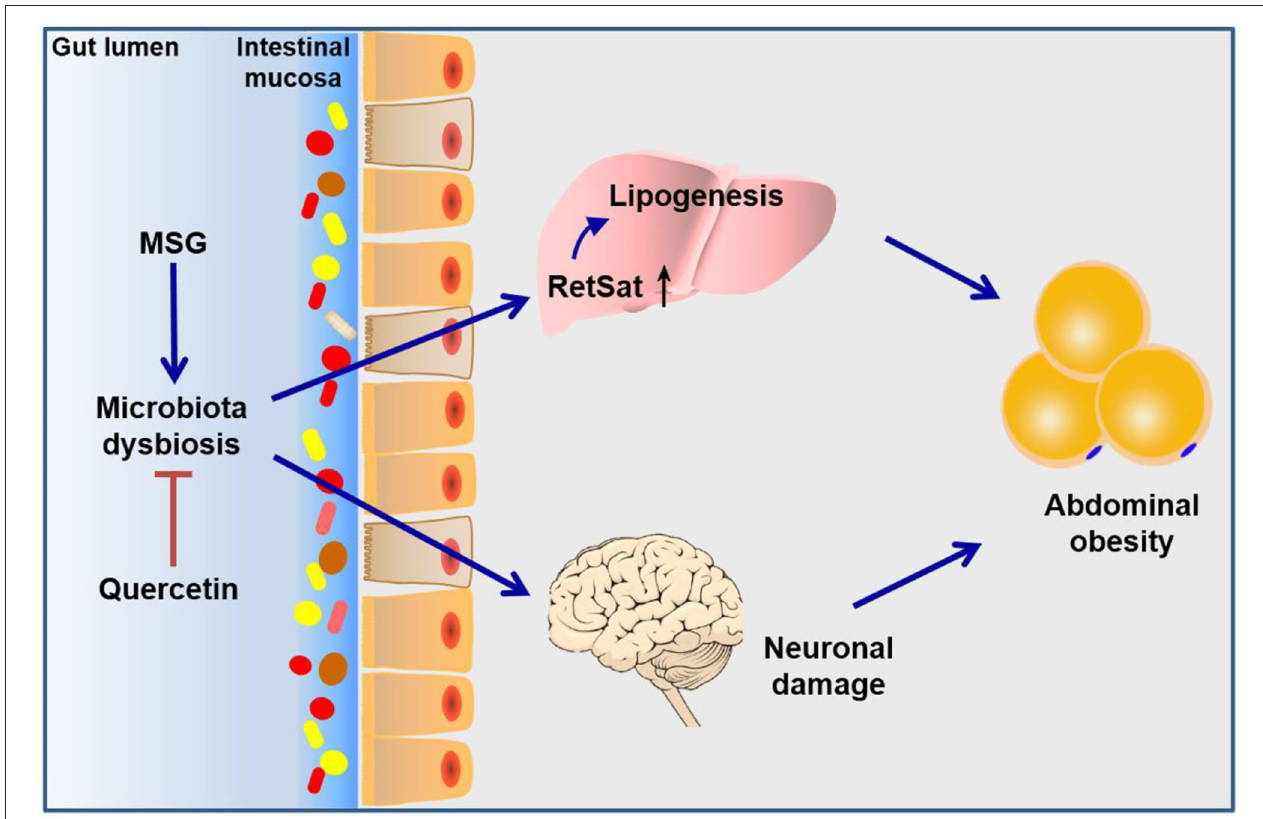
FIGURE 7 | Schematic diagram of the mechanism of MSG-induced abdominal obesity. Our study demonstrated that MSG could cause gut microbiota dysbiosis, leading to up-regulation of RetSat in the liver tissue and neuronal damage in the brain to induce abdominal obesity, which could be ameliorated after quercetin